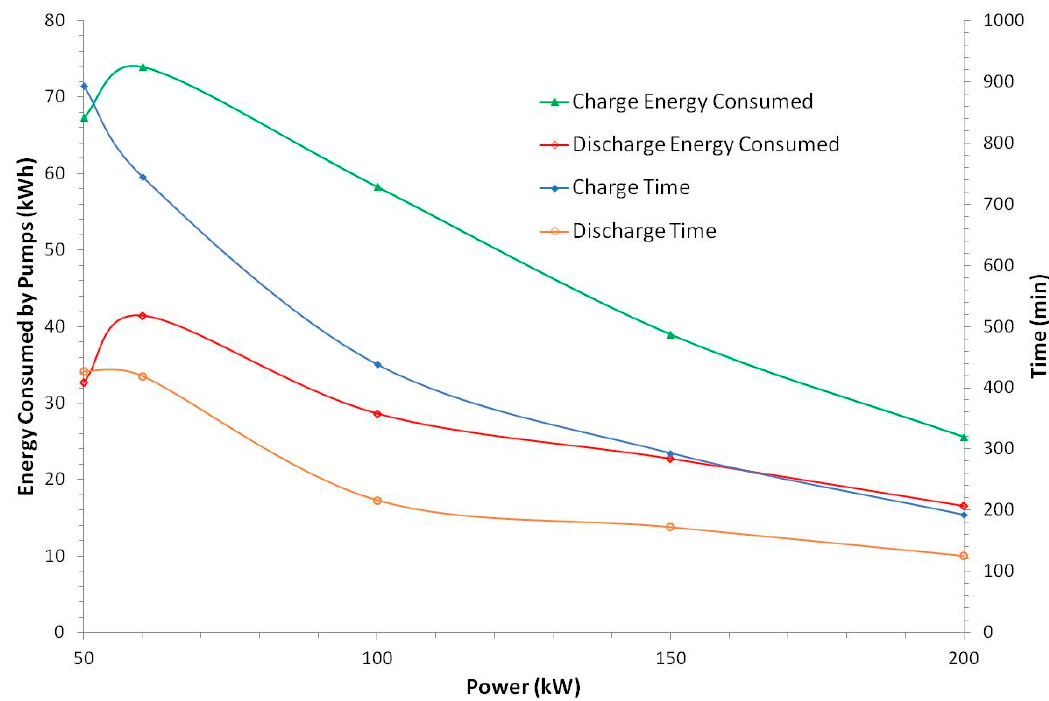
Figure 8. Pump energy consumption and operating periods for all power levels used for charge and discharge.